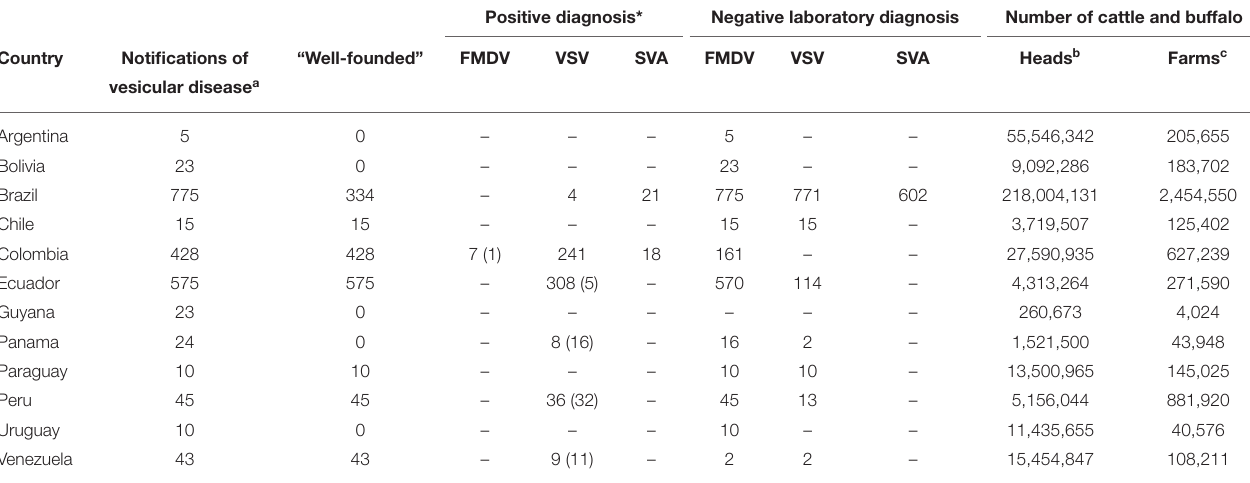
TABLE 4 | Vesicular disease notifications, laboratory diagnoses, and number of cattle and buffalo in South America in